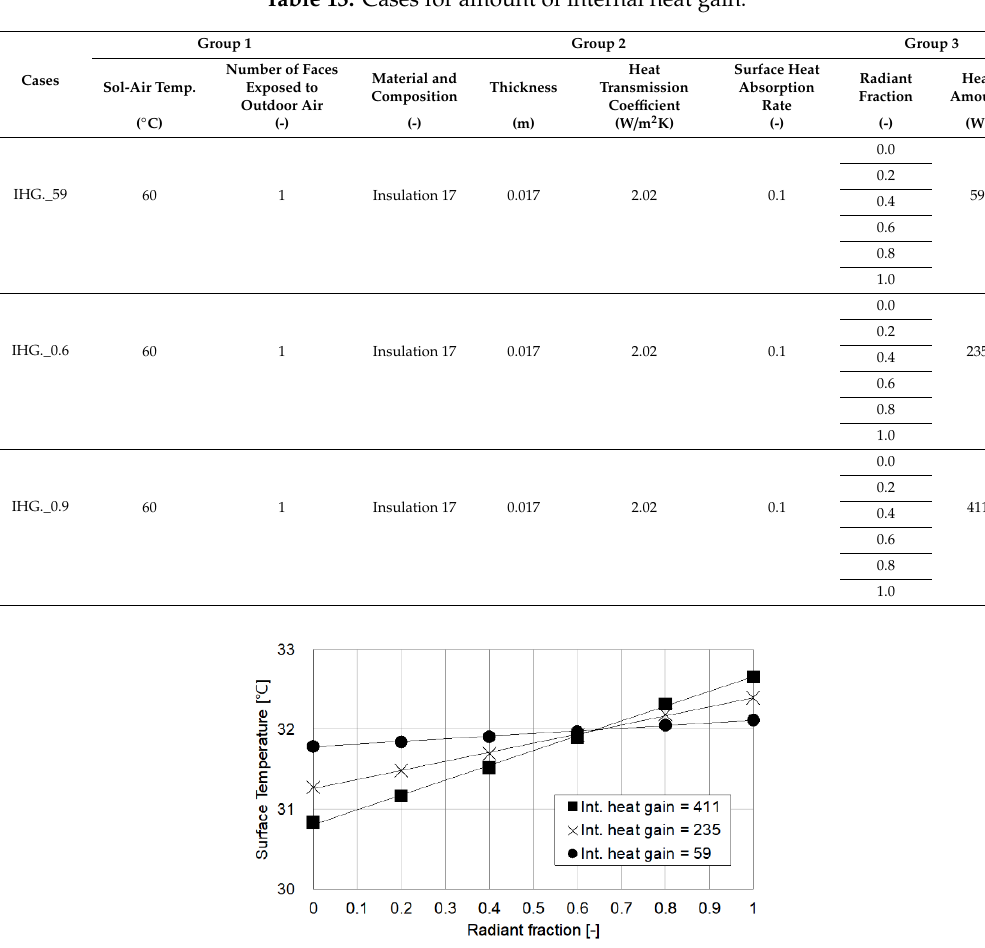
Table 13. Cases for amount of internal heat gain.